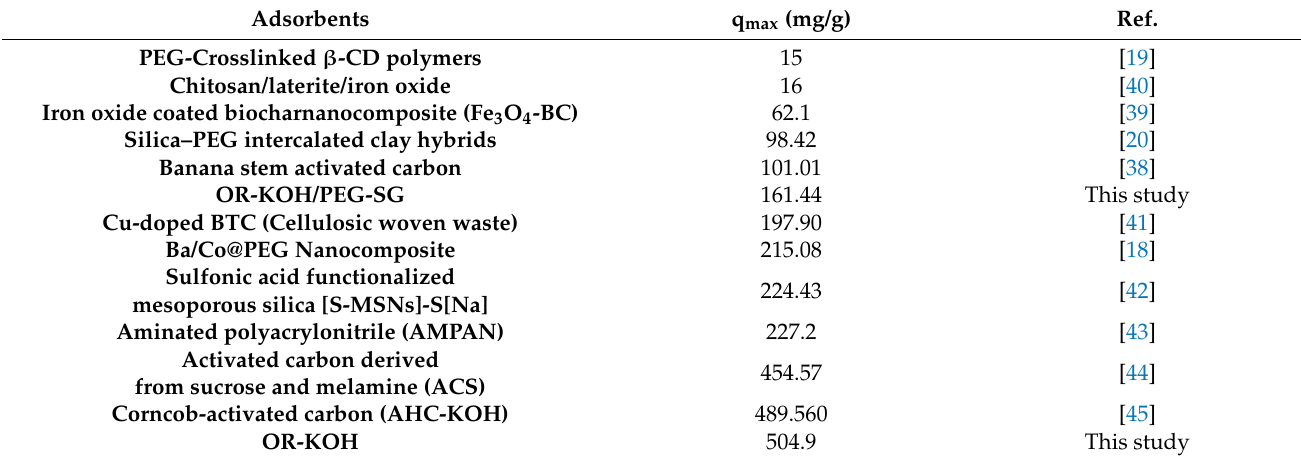
Table 2. Adsorption capacities of OR-KOH, OR-KOH/PEG-SG, and other adsorbents.